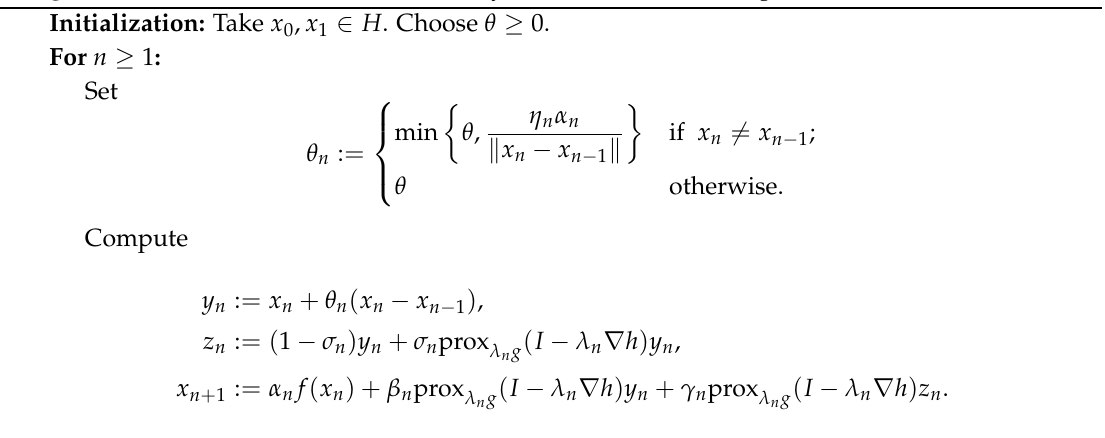
Algorithm 2: AVFBA (Accelerated Viscosity Forward-Backward